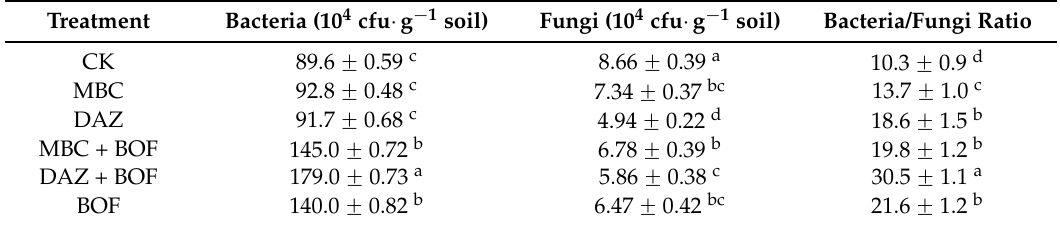
Figure 3. DGGE profiling of soil microbiota: ( a ) the bacterial community; and ( b ) the fungal community. Numbered fragments were excised, re-amplified and sequenced. See footnote to Table 1 for the treatment codes. Table 2. Quantification of soil bacteria and fungi populations based on real-time PCR. Values given in the form mean ± SE ( n = 3) *.